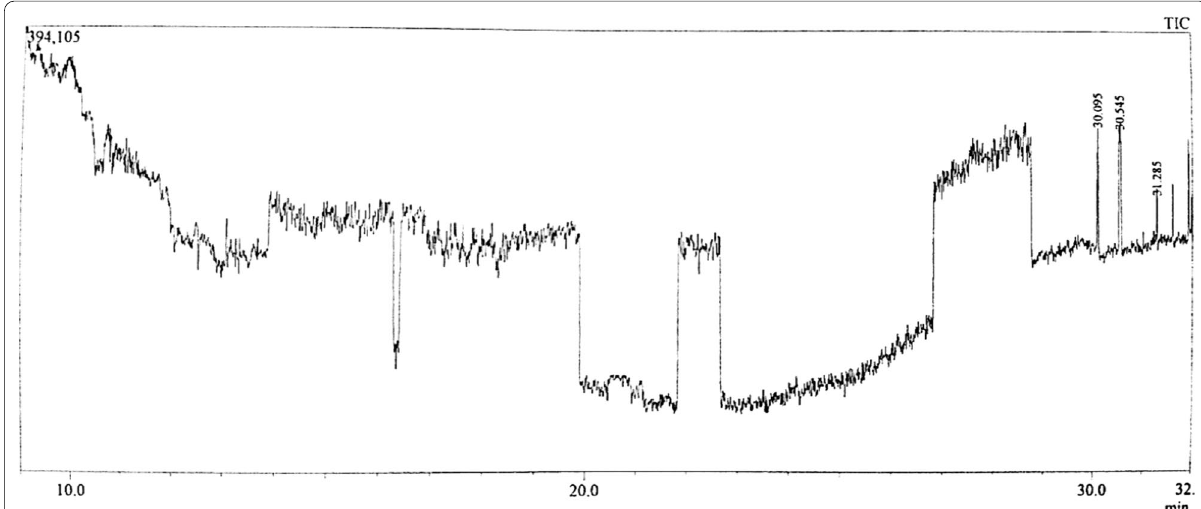
Fig. 1 Total ionic chromatogram (TIC) of methanol extract of W. edulis by GC–MS analysis